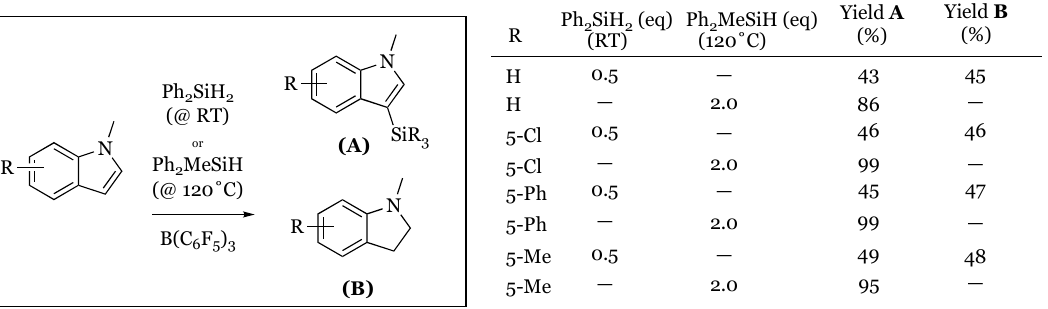
Figure 14. Convergent disproportionation of indoles.